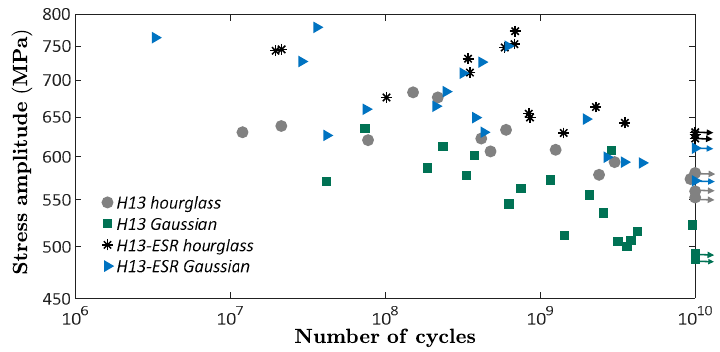
Figure 3. S–N plot of the experimental results.